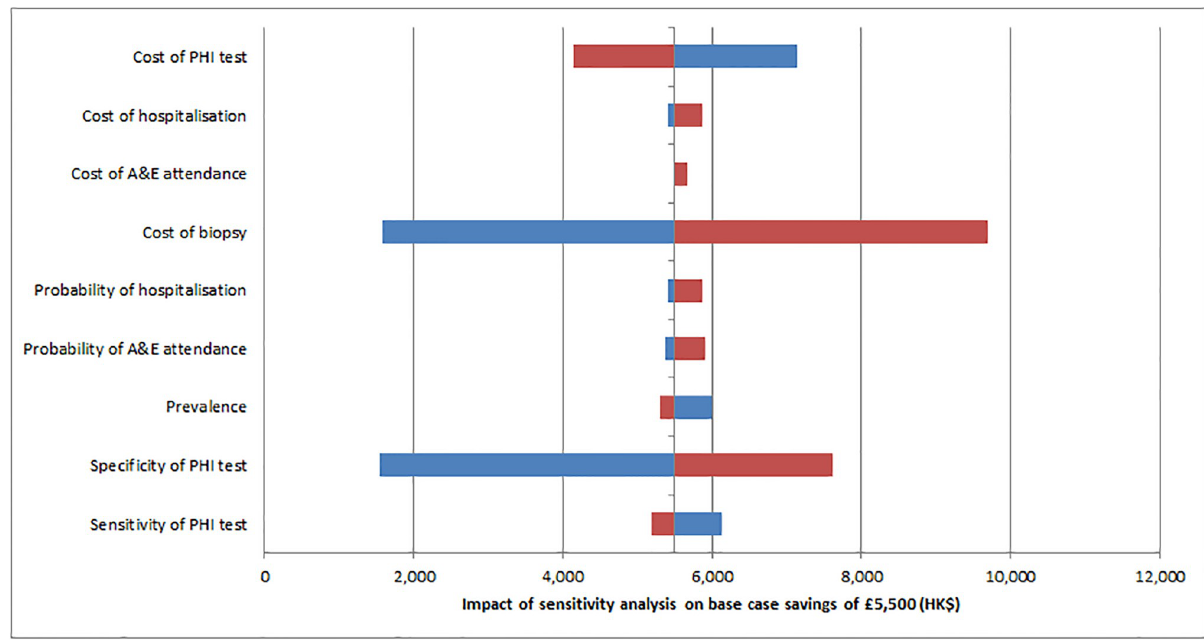
Fig 3. Impact of sensitivity analysis. Each parameter plus/minus 50% PHI–Prostate Health Index, A&E–accident and emergency department, HK$— Hong Kong dollars. Blue reflects the lower bound sensitivity and red the upper bound. Vertical axis crosses at base case savings of HK$5,500.